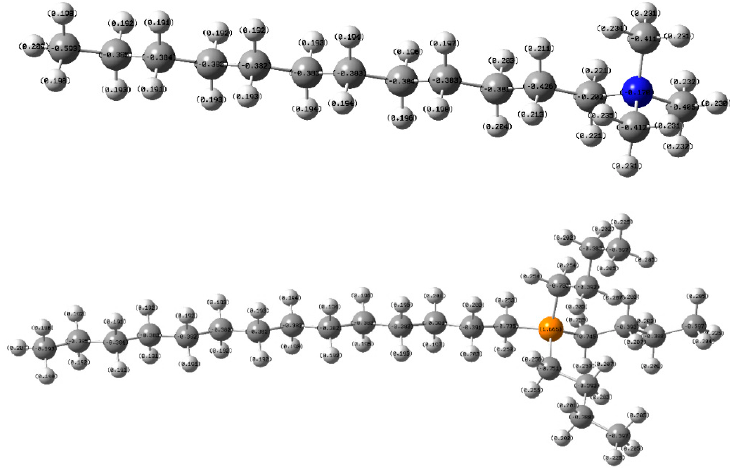
Figure 3. The optimized structures of DTA + ( Top ) and TTP + ( Bottom ) at wB97XD/Def2-TZVP level (Blue—N, Yellow—P, Gray—C, and White—H). Table 2. The frontier molecular orbital eigenvalues of the DTA + and TTP + collectors at wB97XD/Def2- TZVP level, unit is in Kcal/mol.